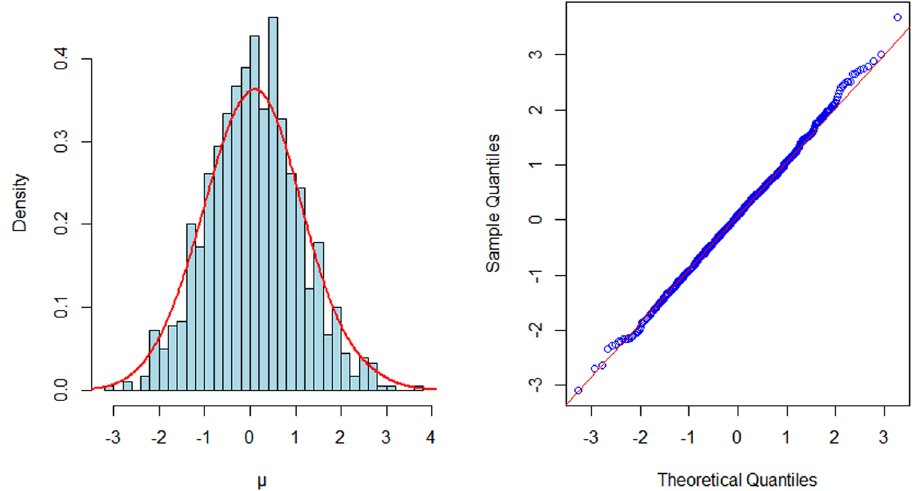
Figure 3: Histogram and normal Q – Q plot